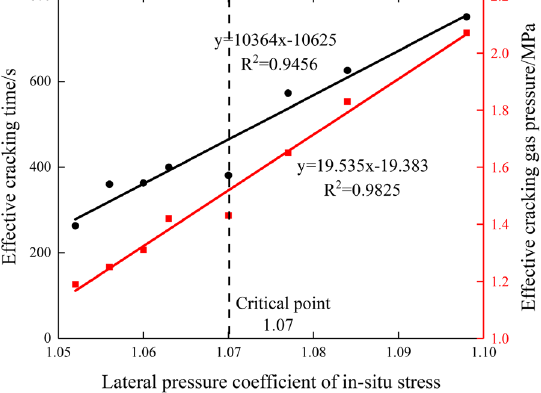
Fig. 6 Variation of effective cracking time and effective cracking gas pressure with the lateral pressure coefficient of in-situ